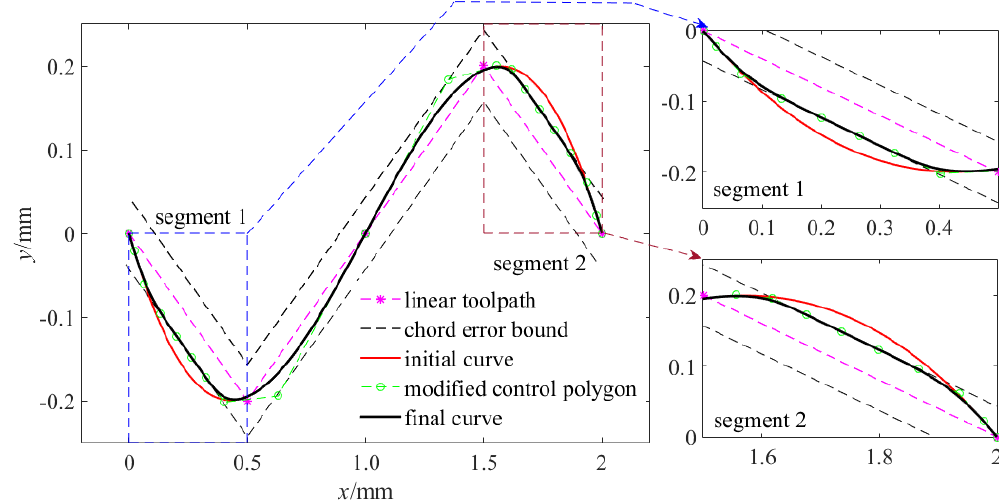
Figure 3. Fitted curve of planar five-point example.